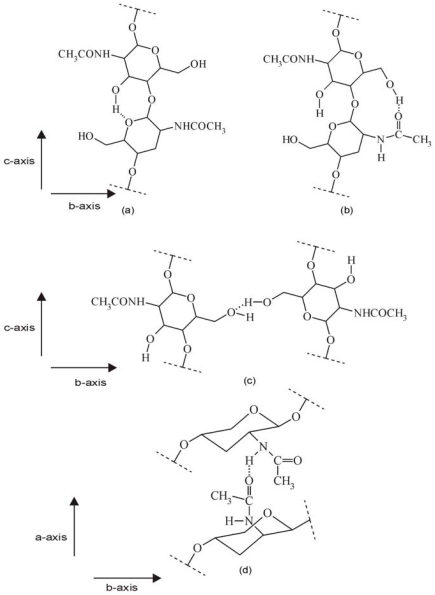
Modes of hydrogen bonding in α-chitin: (a) intrachain C(3′)OH···OC(5) bond; (b) intrachain C(6′1)OH···O=C(71) bond; (c) interchain C(6′1)O···HOC(62) bond; (d) interchain C(21)NH···O=C(73) bond. Adapted with permission from Biomacromolecules. 2000, 1, 609–614. Copyright 2010, American Chemical Society [18].